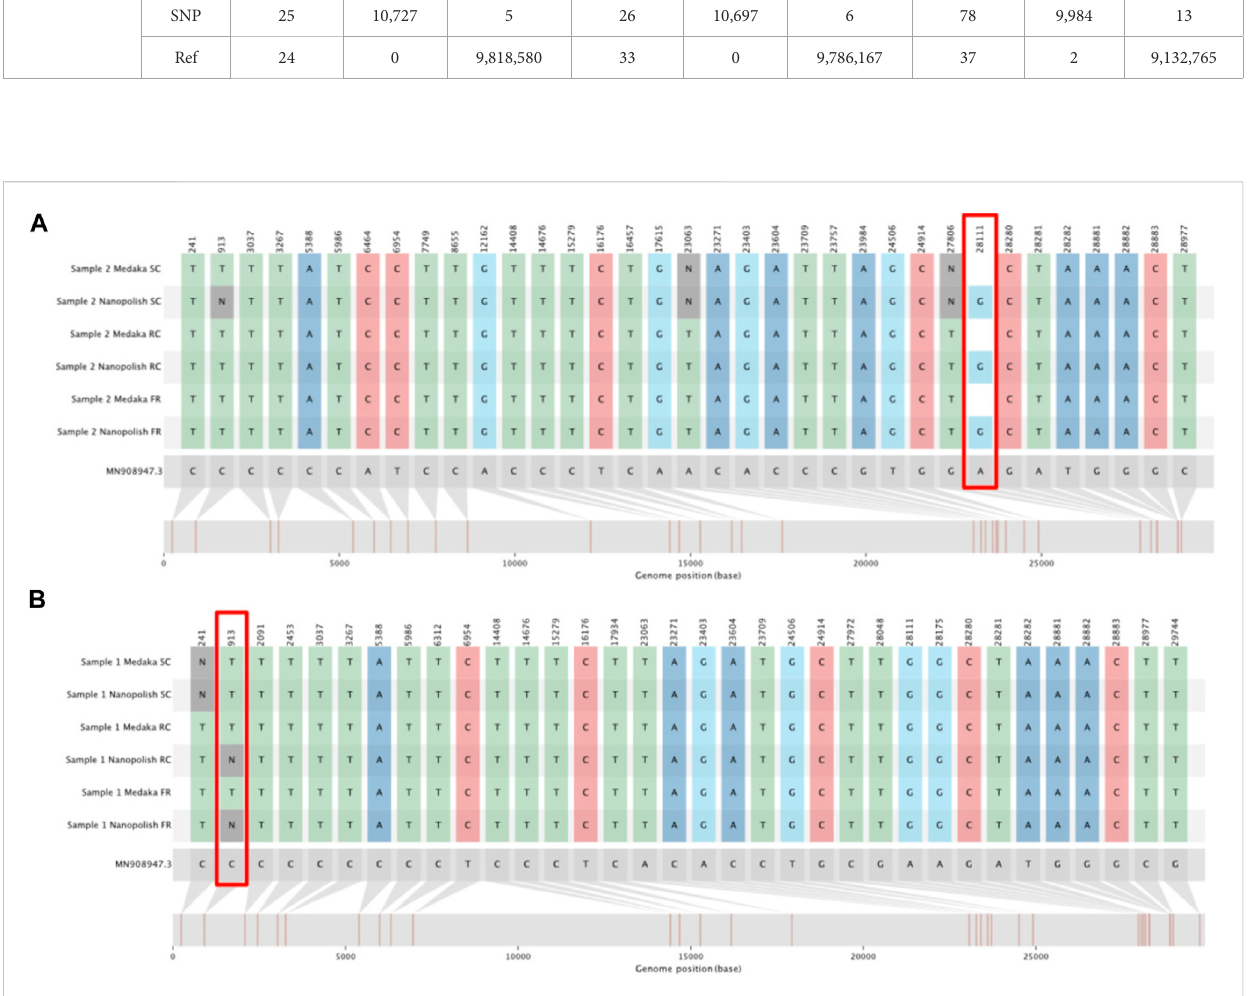
FIGURE 5 SNIPIT plots demonstrating particularly divergent positions for SNP calls between Medaka and Nanopolish. The tracks from top to bottom show SNPs as called from consensus genomes for the Sample Complete time, Run Until and Full run time points (in this order) for both the Medaka and Nanopolishpipelines. (A) SNIPITplotshowinganexamplepairofconsensusgenomeswithNanopolishcalling aSNPatposition28111 butMedaka calling reference. (B) SNIPIT plot, showing the Nanopolish pipeline switch from a SNP to an N atposition 913 with more data, on a single sample across our three time